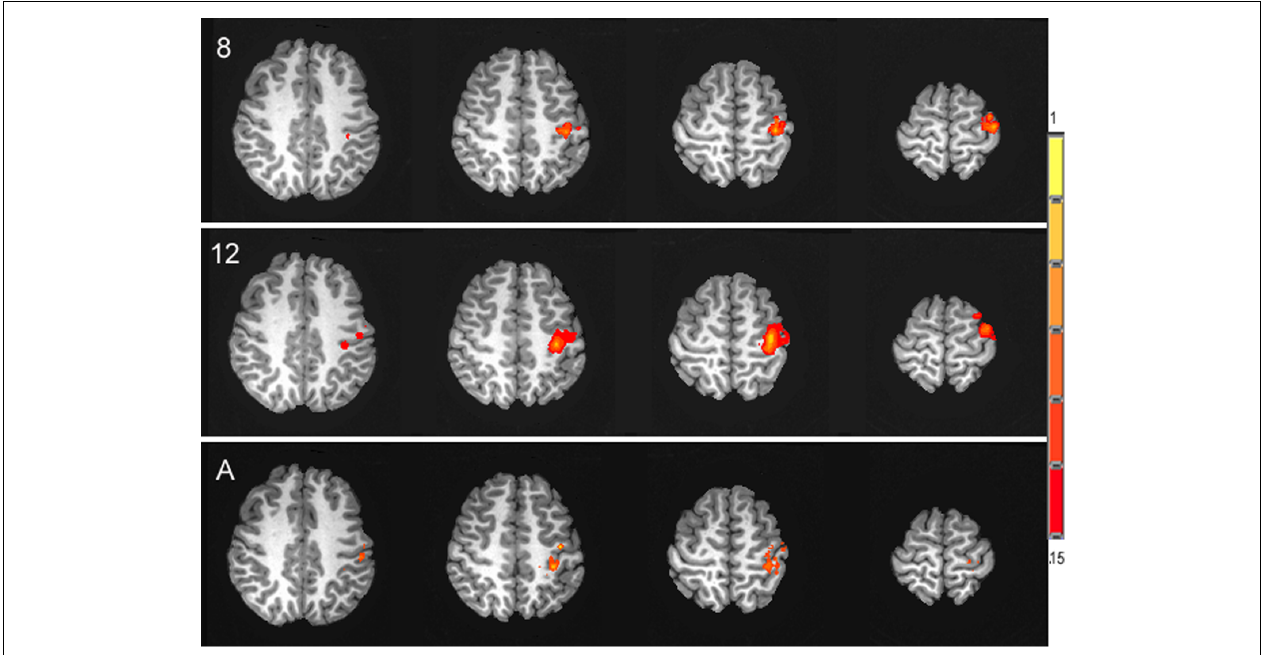
FIGURE 4 |Activation maps of the spatial distribution of the task-related CBF response in each of the three age groups, 8 year olds (8), 12 year olds (12) and adults (A), presented in the axial plane in radiological orientation. Signal intensity is represented in the color scale.